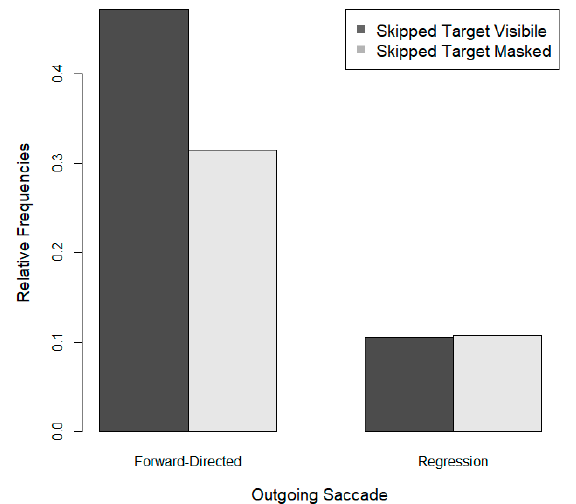
Figure 1. The relative frequencies of saccades out of post-target words after the preceding three-letter target area had been skipped. Relative frequencies are shown as a function of the visibility of the target word prior to the skipping of the target area and as a function of the direction of the outgoing saccade (relative frequencies add up to 1).